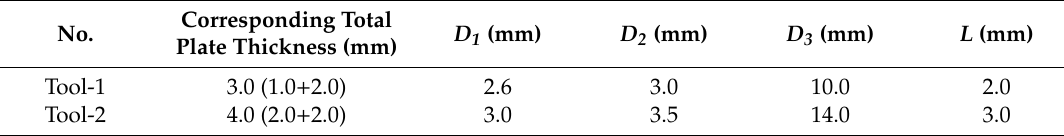
Table 4. FSSW process factors and their feasible range adopted in this